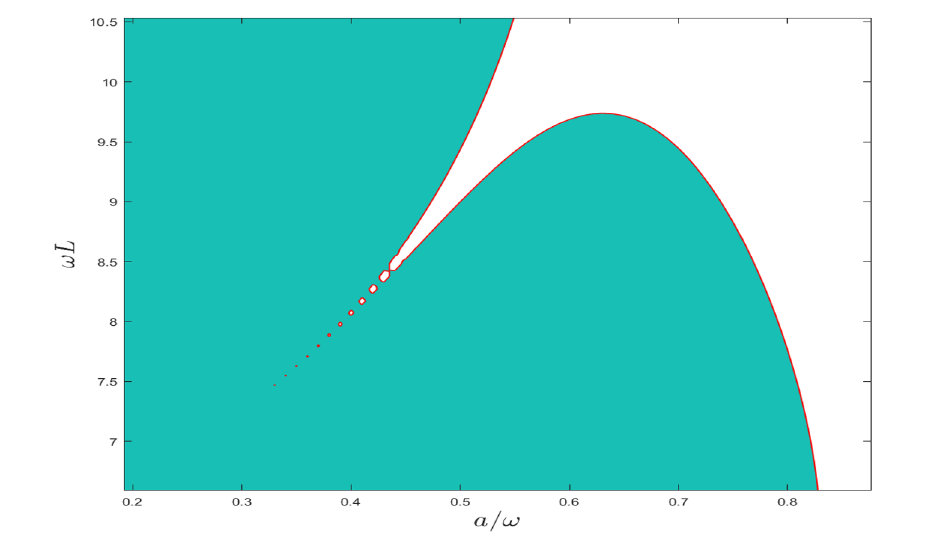
Figure 6 . Partially amplified figure of the D = 4 case of figure